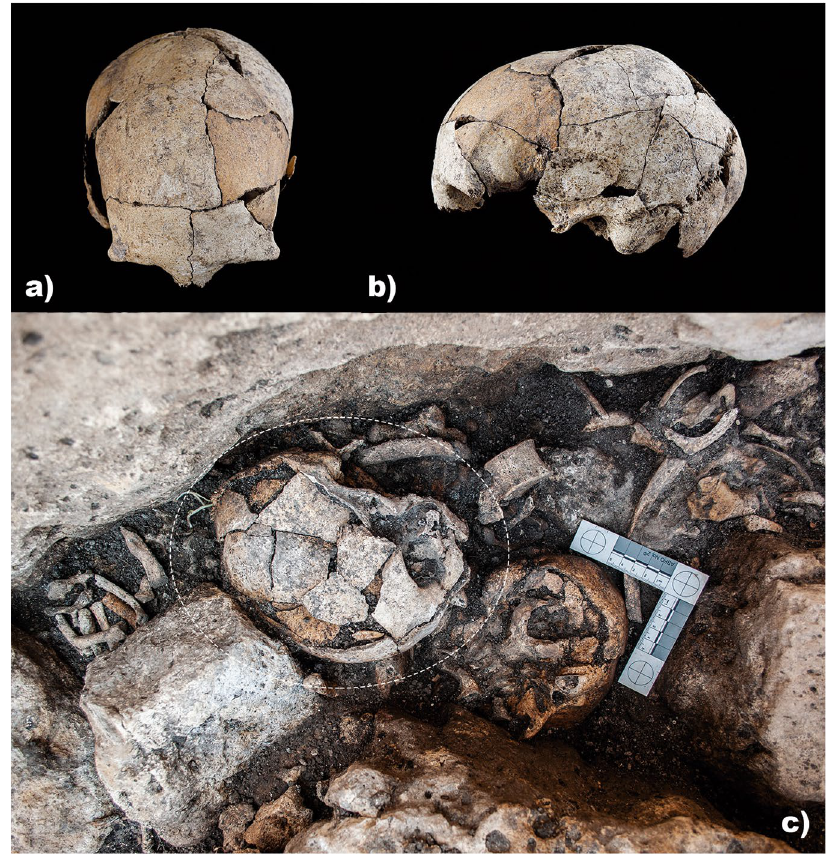
Figure 3. Skull under study found at El Pendón site. Superior: Frontal and lateral view of the skull (Photo: ÑFotógrafos Photography Study). Inferior: Skull with mastoidectomy in situ in the context of the megalithic